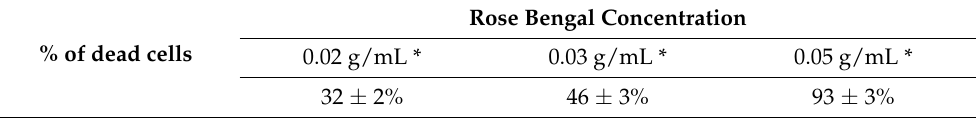
Rose Bengal Concentration